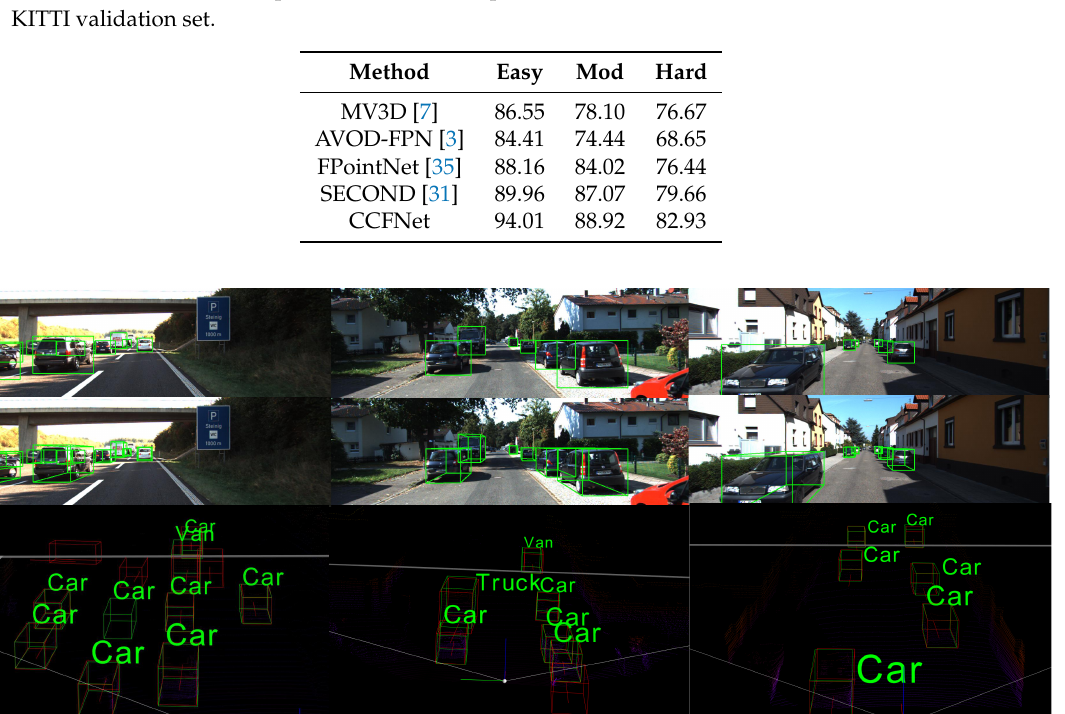
Figure 4. Qualitative performance of or approach on the KITTI validation set. The red 3D bounding boxes denote the ground truth bounding boxes and the green one is our